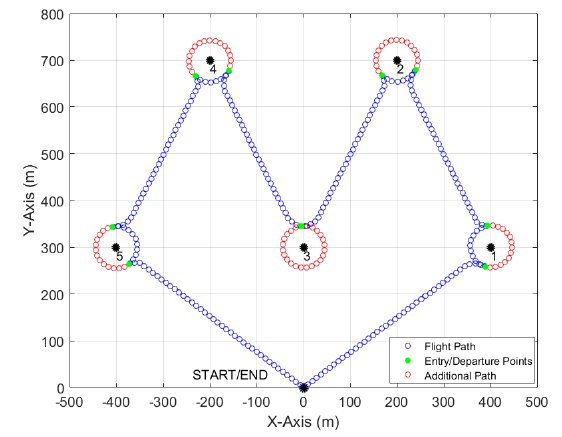
Figure 12. Least distance smart loitering path for five